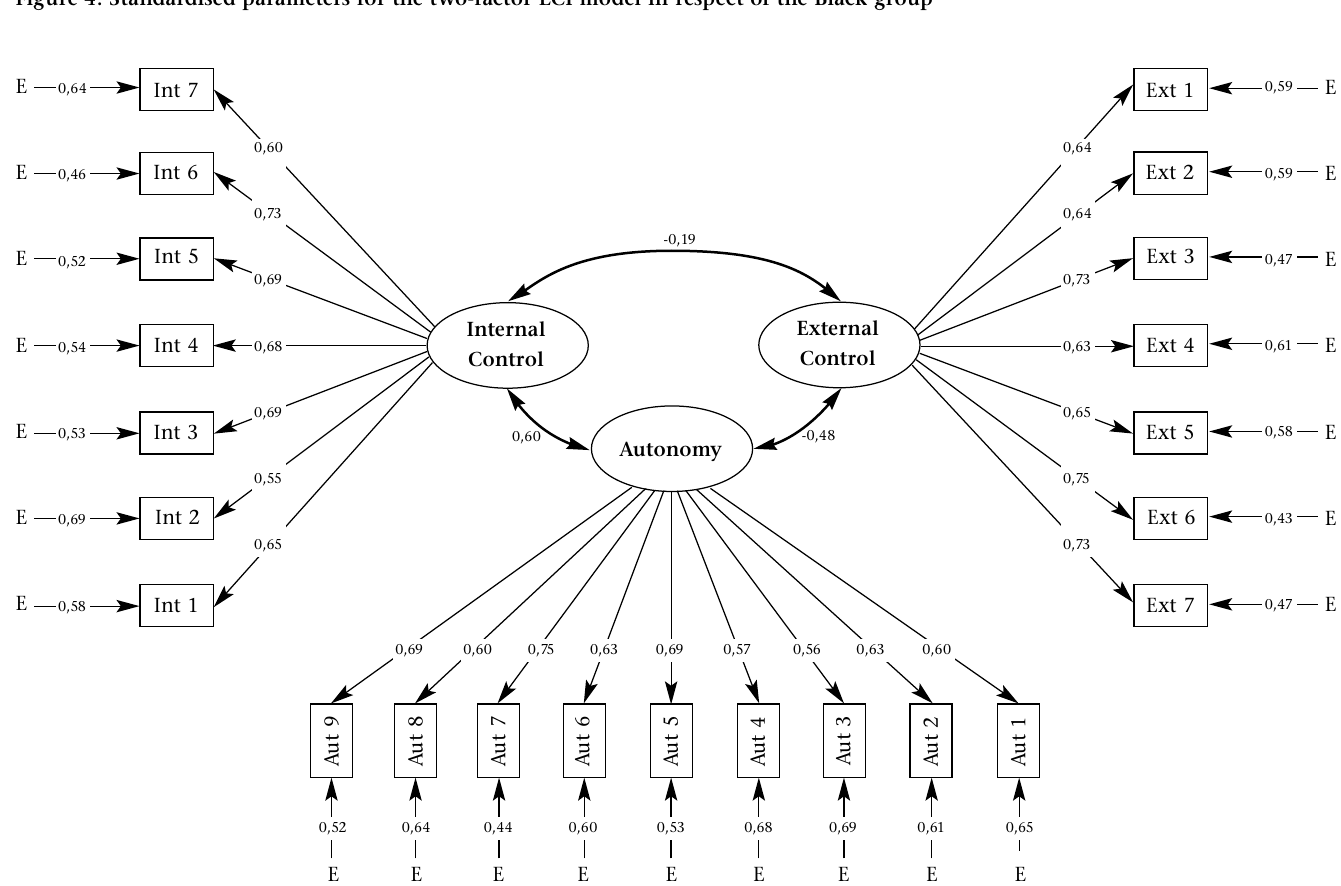
Figure 5: Standardised estimated parameters for the three-factor LCI model in respect of the White